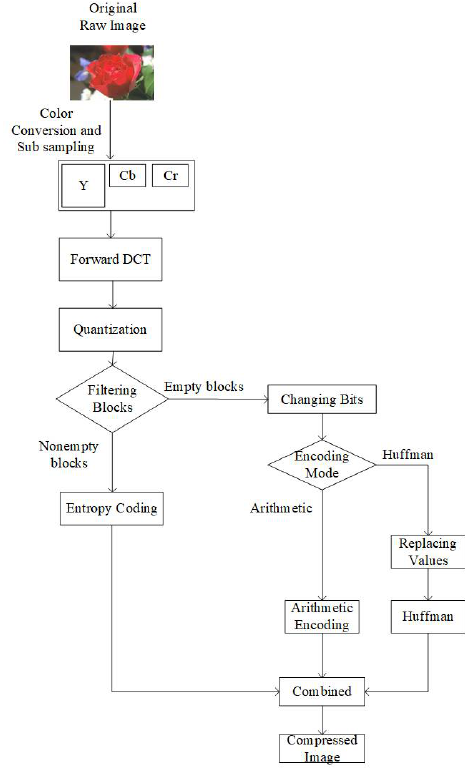
Figure 2. Overview of the proposed JPEG encoder .